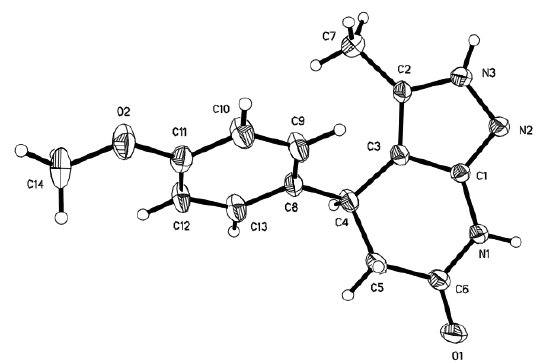
Figure 1. Molecular structure of 4c